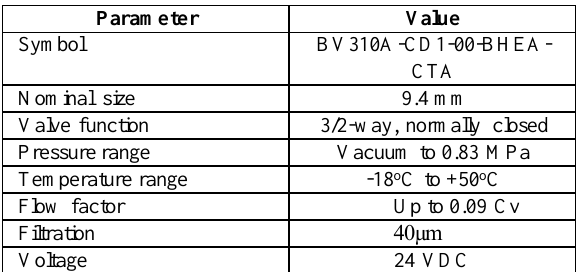
Table 2. Parameters of the valve BV310A-CD1-00-BHEA- CTA.